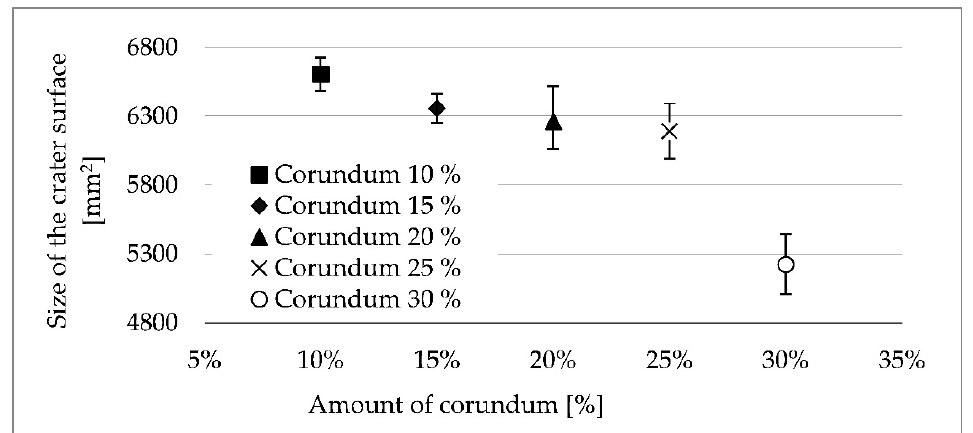
Figure 12. Diameter of the entrance crater according to the individual percentage substitutions.